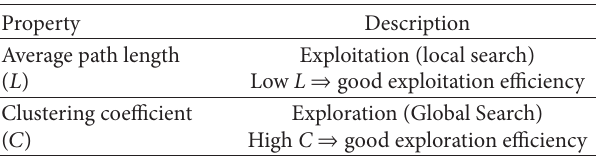
Table 1: Efficiency of average path length ( 𝐿 ) and clustering coefficient ( 𝐶 ).